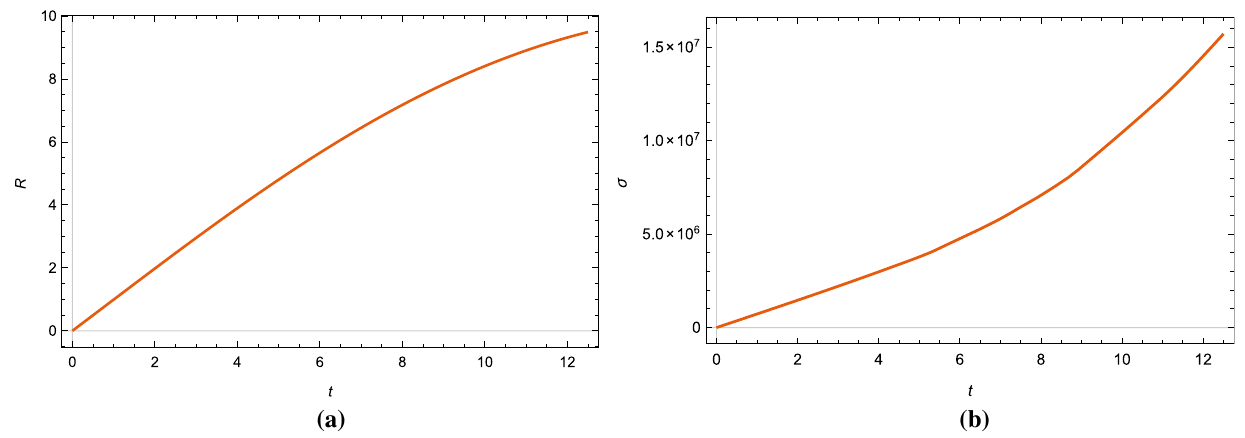
Fig. 6 Evolution of the true vacuum bubble for γ f = 1 . 3. a Radius of the bubble as a function of time t + . b Surface energy density as a function of time t +